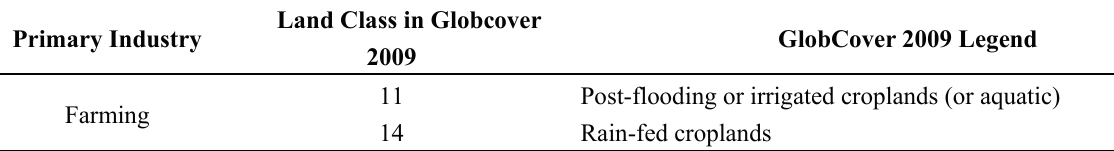
Table 1. Land cover classes before and after